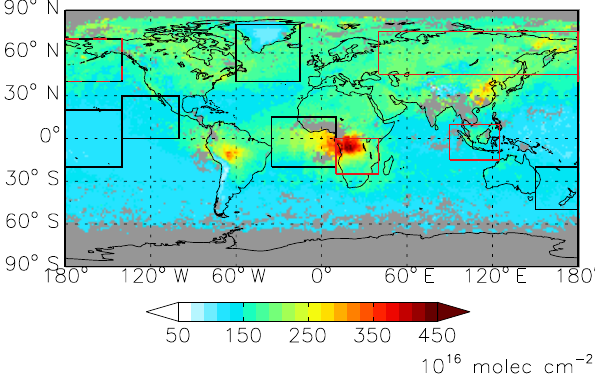
Figure 8. MOPITT CO column for August 2016 overplotted with the regions shown in Fig. 10. Black rectangles indicate the regions where we analyze CO concentrations, and red rectangles indicate the regions used for biomass